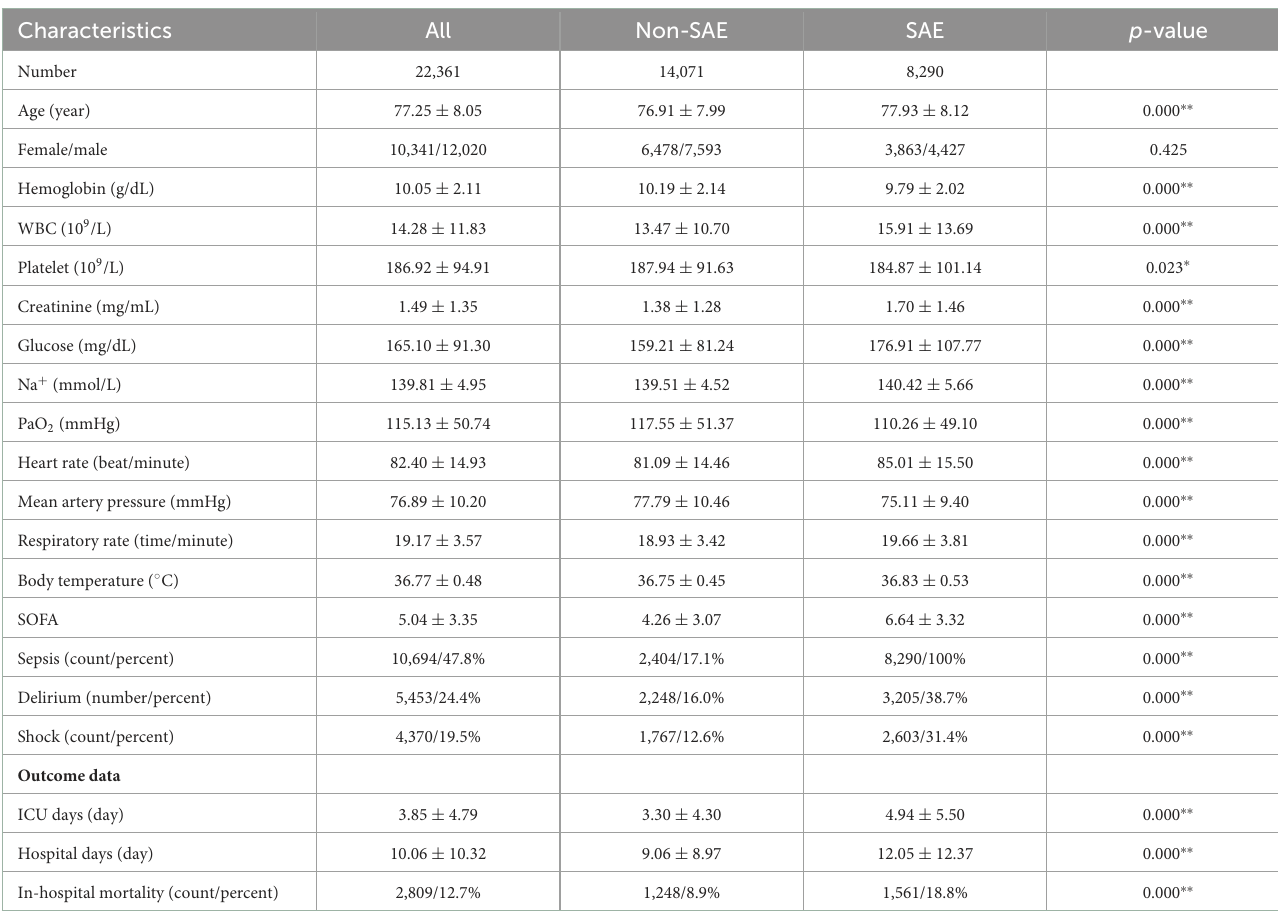
TABLE 1 Baseline characteristics and outcome data in SAE and non-SAE groups.